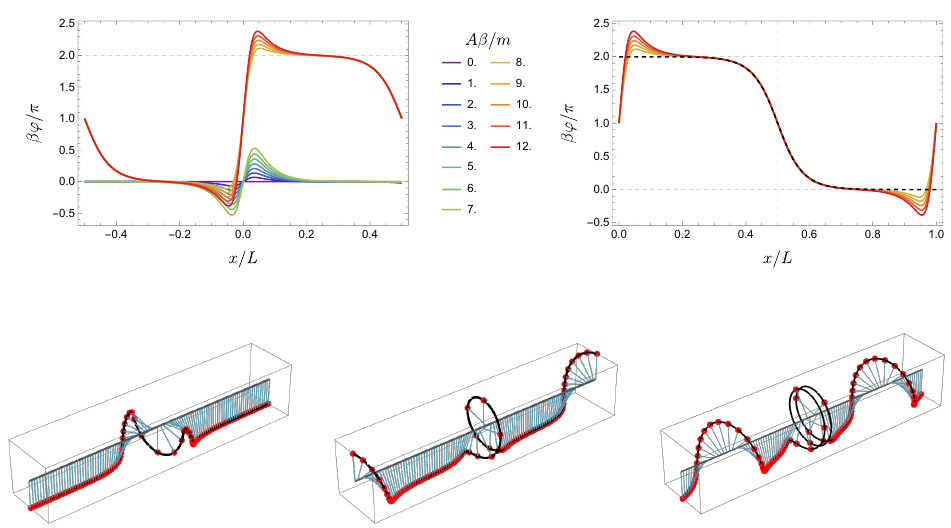
Figure 4.2: Upper row left: Classical initial states on the two sides of the first trans- ition at (cid:96) = 20, m σ = 4 / 9. Different curves correspond to different amplitudes as indicated in the legend. Upper row right: The profiles above the transition point ≈ 7.856 m /β (c.f. Table B.1) match perfectly around x = L / 2 ( A > A where A cr cr to the profile of an antisoliton in a rotated frame. Lower row: Illustration of the realisation of three types of classical initial states on a chain of coupled pendulums obeying the discretised sine–Gordon equation. The leftmost one corresponds to the type of profiles observed for A < A , while the middle one corresponds to the type cr of profiles observed for A > A which exhibit a 2 π -twist of the phase at the loc- cr ation of the external source and an antisoliton configuration located the antipodal point on the circle. If A is increased even further, then above a second critical value ≈ 14.412 m /β a second twist emerges in the middle together with a correspond- A cr2 ing second antisoliton, as shown in the rightmost